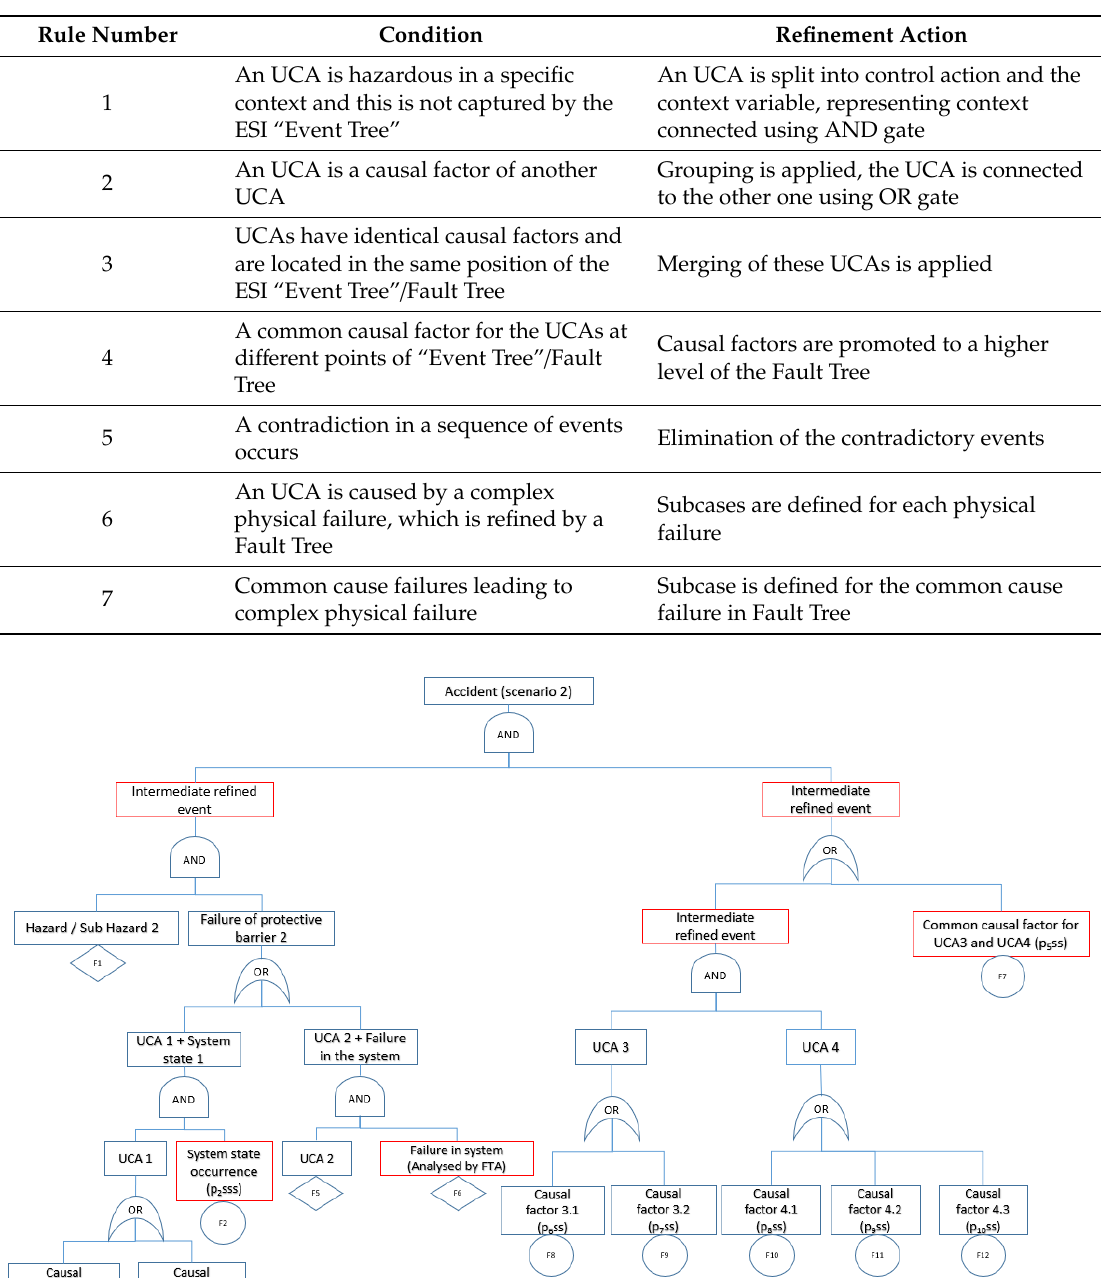
Table 2. Conditions for the FT refinement and refinement actions.